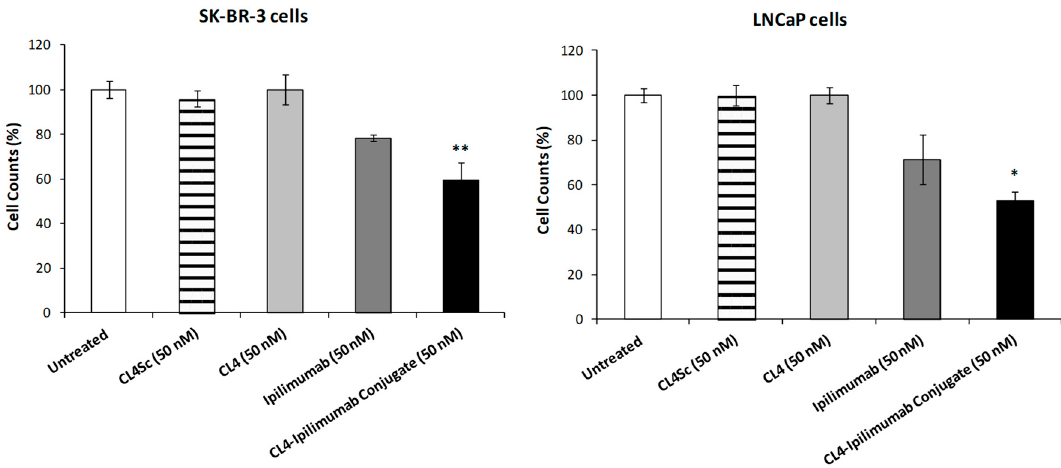
Figure 3. Effects of CL4-ipilimumab conjugate on tumor cell growth. Cell growth inhibition assays on SK-BR-3 and LNCaP cells, treated with CL4 aptamer (light grey bars), ipilimumab mAb (dark grey bars), or CL4-ipilimumab conjugate (black bars) for 72 h. Untreated cells (white bars) or cells treated with CL4Sc (striped bars) were used as negative controls. Error bars depict means ± SD. p-values for the indicated immunoconjugate relative to ipilimumab treated cells are: ** p < 0.01; * p < 0.05.